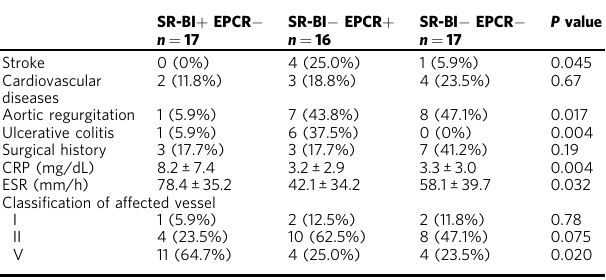
Table 1 Statistical comparison among 50 Takayasu arteritis patients with or without anti-EPCR or anti-SR-BI autoantibodies.